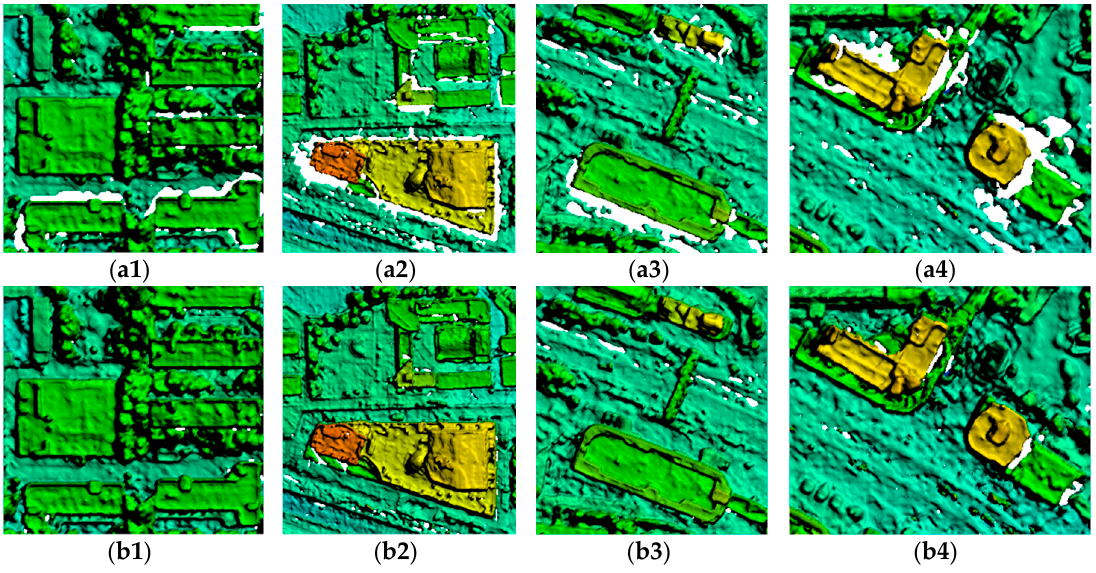
Figure 12. Subsets of the DSM without (a1–a4) and with handling occlusion(b1–b4). Points with very high matching cost (larger than 0.95) have been removed and depicted with white color.